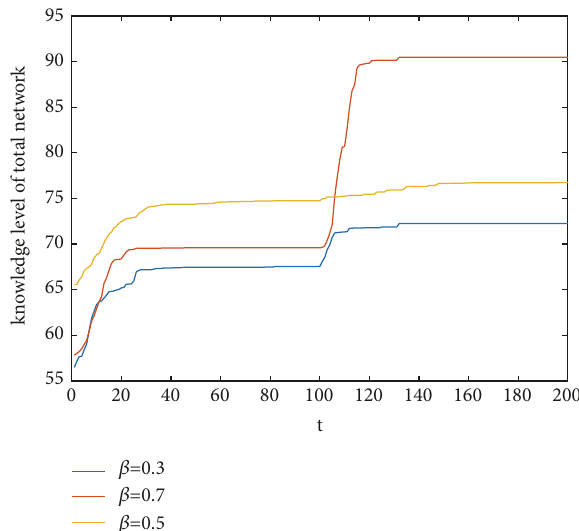
Figure 8: The evolution picture of the collaborative innovation network‘s total technological knowledge levelunder different values of 𝛽